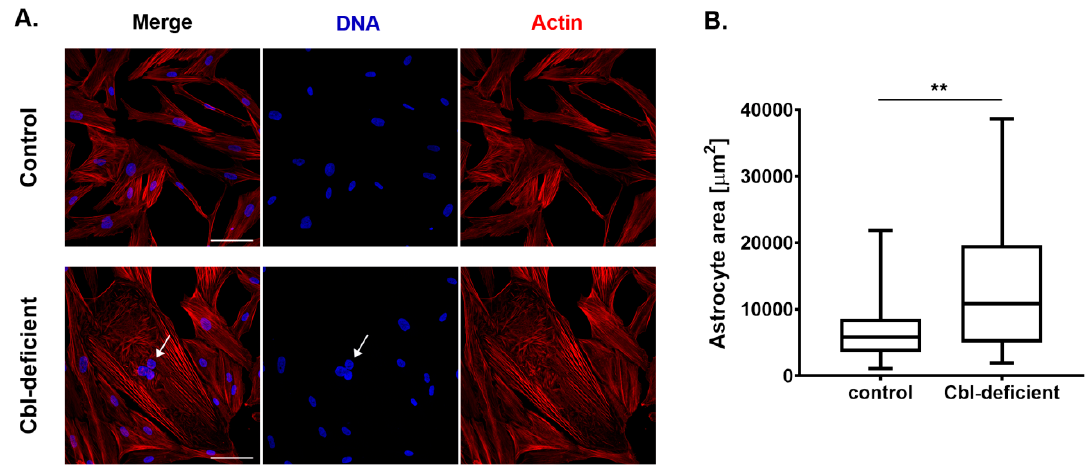
Figure 3. Hypovitaminosis B12 results in astrocytes hypertrophy. ( A ) Representative confocal images of control and cobalamin-deficient normal human astrocytes; arrows indicate multinucleation; scale bar shows 100 µm. ( B ) Cell size (area) was evaluated from the confocal images. Data acquired from at least three independent experiments are presented as box plots. The boxes show, from bottom to top, the 25th percentile, median, and 75th percentile values, and the whiskers indicate the maximum and minimum values. More than 300 cells from different randomly selected microscope fields are analyzed for each condition. The cells that were fully visible were bordered manually and the area of the cell body was determined using ImageJ software. Statistically significant differences are designated as ** p < 0.01 for comparisons between groups using unpaired t-test.